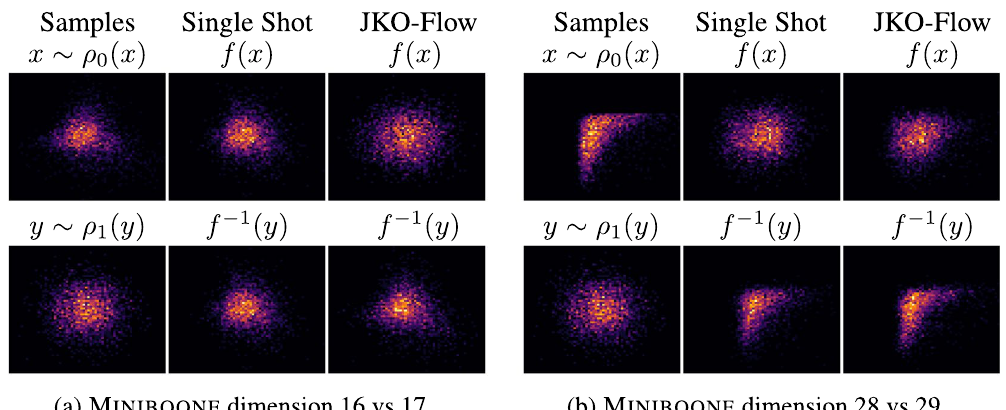
Figure 4. Generated samples for the 43-dimensional Miniboone dataset using the single shot approach and JKO-Flow with 10 iterations. To visualize the dataset, we show 2-dimensional slices. We show the forward flow f ( x ) where x ∼ ρ 0 and the genereated samples f − 1 ( y ) where y ∼ ρ 1